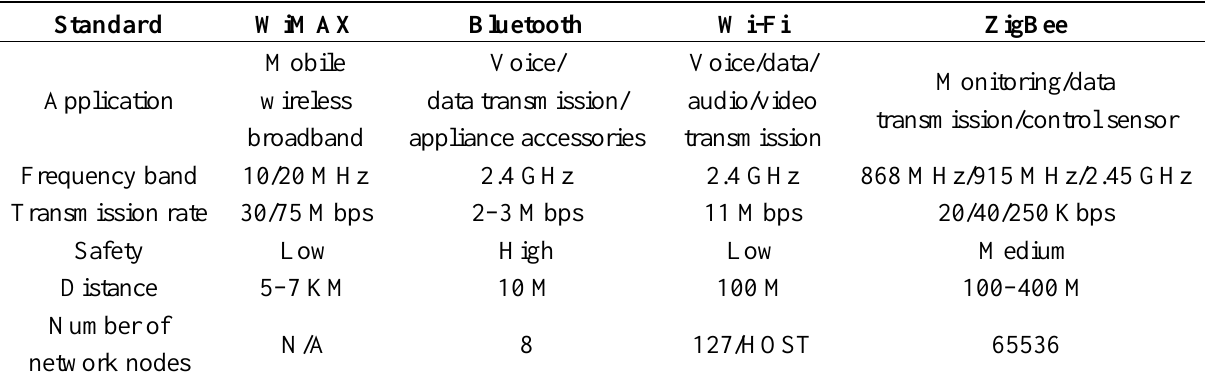
Table 1. Comparison of wireless transmission